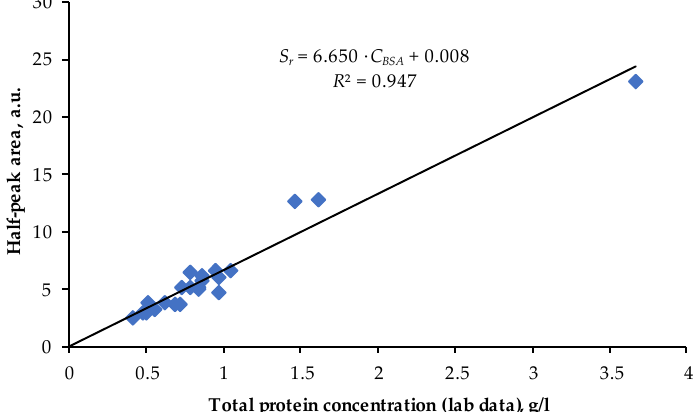
Figure 7. Dependence of the first peak half-area in the chromatograms of peritoneal dialysate samples from the protein concentration measured by laboratory biochemical analysis.